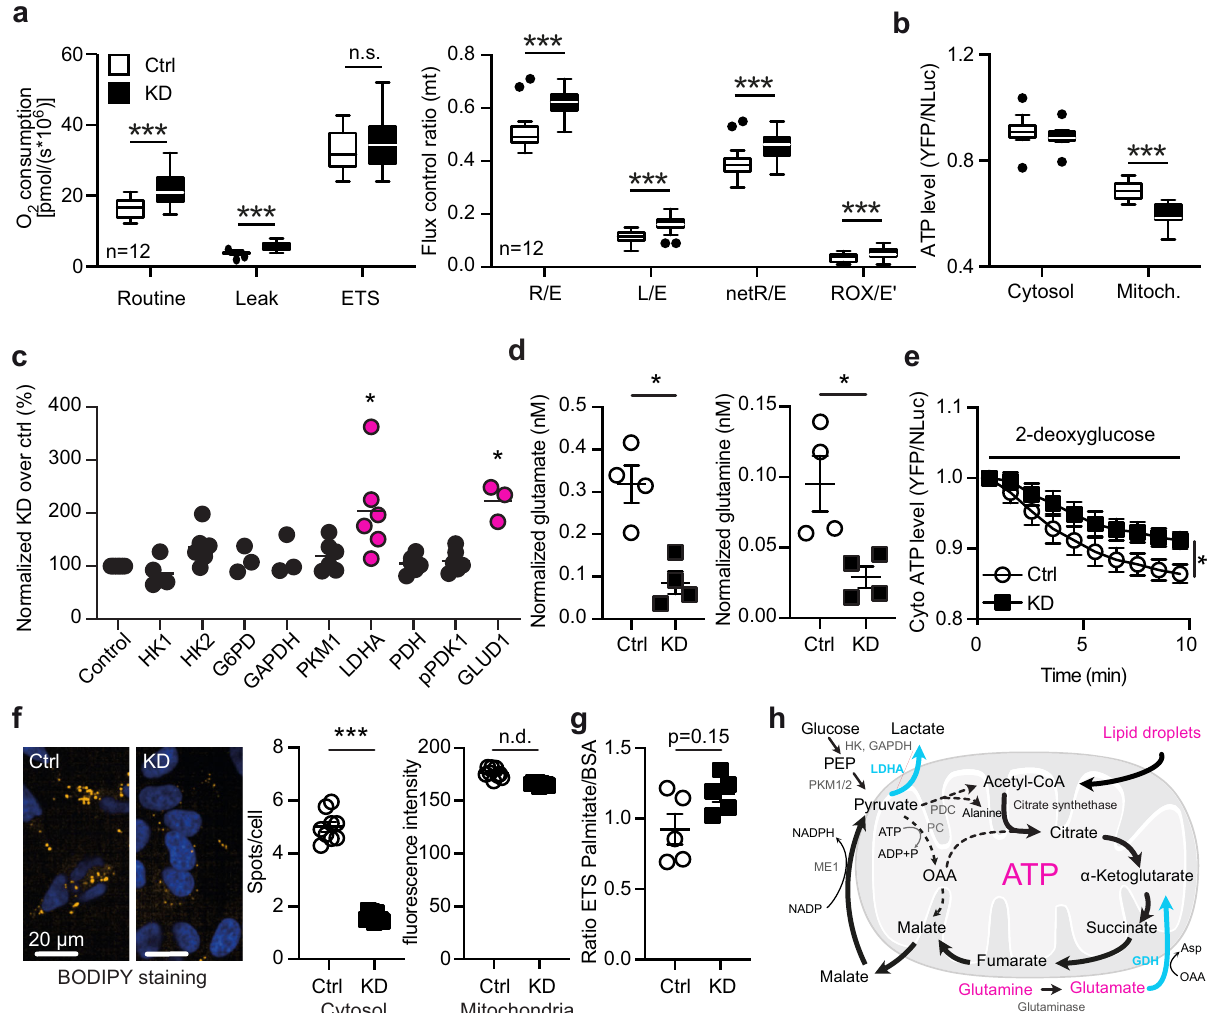
Fig. 2 GDAP1 knockdown uncouples mitochondrial respiration from ATP generation and shifts metabolism towards glutaminolysis. a Mitochondrial oxygen consumption of intact cells in regular growth medium measured by high-resolution respirometry and corrected for ROX. ETS, electron transfer system; L, leak respiration; R, routine respiration; E, ETS capacity; ROX, residual oxygen consumption; netR, oxygen consumption minus ROX. Calculation of fl ux control ratios. b Comparison of cytosolic and mitochondrial ATP content using the genetically encoded ATP sensor BTeam. Calculation of BTeam YFP/ NLuc emission ratios under basal conditions revealed reduced mitochondrial ATP levels. c Immunoblot quanti fi cation of proteins involved in glycolysis in Ctrl and KD cells shows an increase in lactate dehydrogenase A (LDHA) and glutamate dehydrogenase 1 (GLUD1) levels. HK, Hexokinase; G6PD,